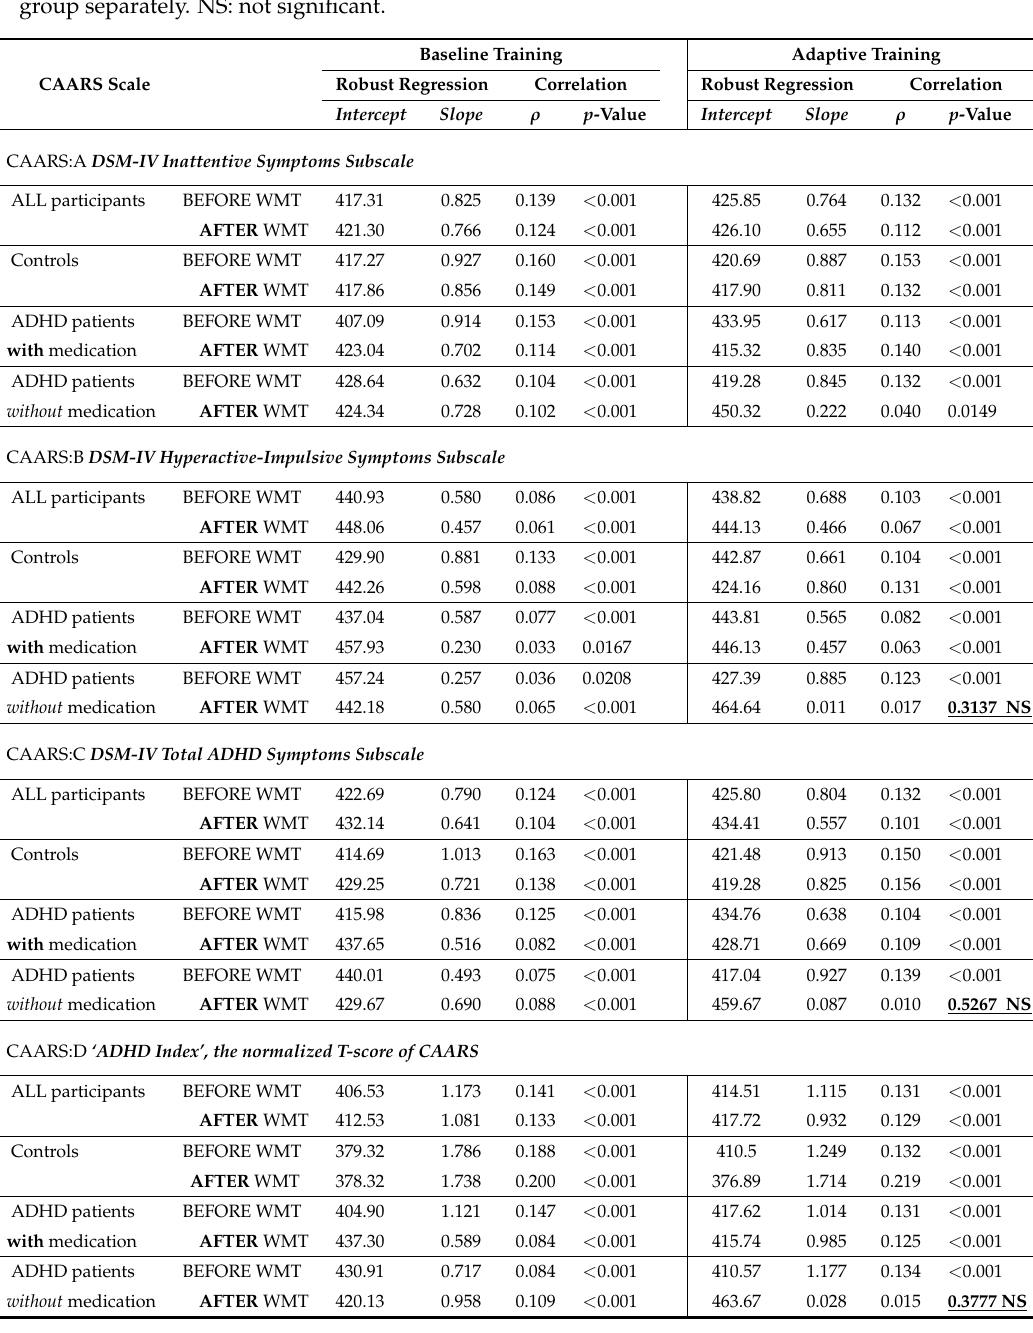
Table 2. Descriptive statistics for robust linear regression y = a + b x (a : intercept, b: slope) and for Spearman’s rank correlation (rho and p -value) between reaction times and four CAARS scores associated with symptoms severity. Analysis is reported for all participants merged into the same sample, assuming that the correlation depends only on the scored symptoms and for each participants’ group separately. NS: not